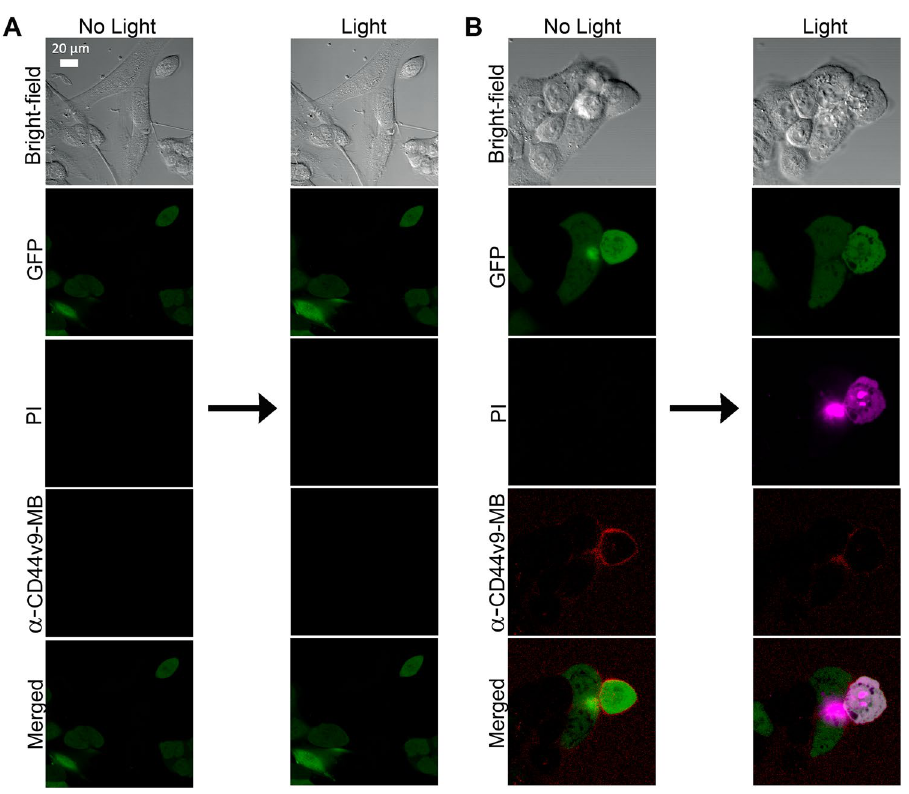
Figure 5. Targeted photoimmunotherapy of CD44v8-10( + ) cancer cells using anti-CD44v9-MB conjugate. Results obtained with CD44( − ) HDF/CD44( − ) Mock MKN-28 cell combination ( A ) and CD44( − ) MKN- 28/CD44v8-10( + ) MKN-28 cell combination ( B ). Cells were treated with anti-CD44v9-MB conjugate (8.96 μ g/0.3 mL, 0.2 μ M MB equivalent) for 1 h, and then the cells were irradiated with 633-nm laser light. Scale bar indicates 20 μ